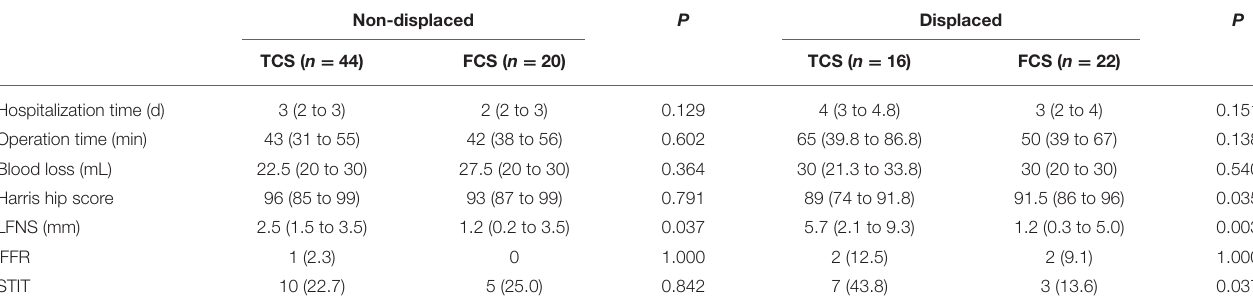
TABLE 3 | Comparison of displaced and non-displaced femoral neck fractures at the latest follow-up.